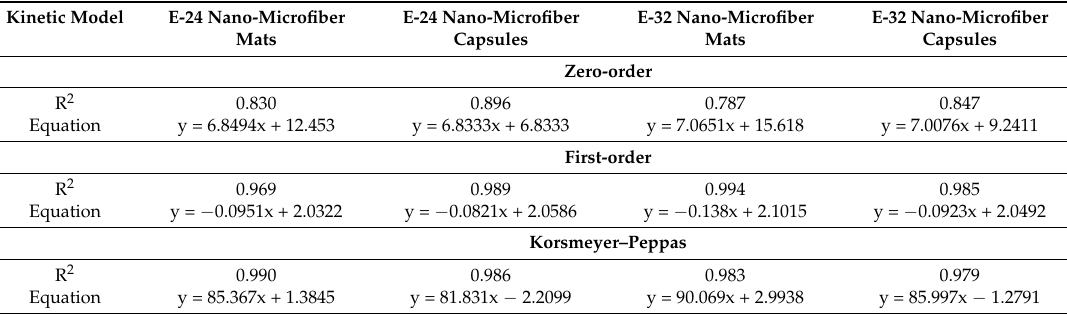
Table 3. Kinetic release profile model analysis of carvacrol from E-24 and E-32 formulations. Kinetic